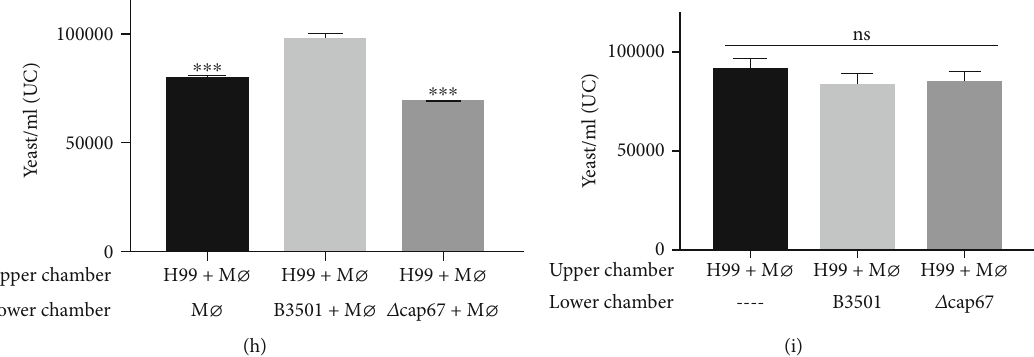
Figure 4: 1 kDa CM35 impacts phagocytic capacity and vomocytosis events in interactions between macrophages and C. neoformans . (a) Intracellular growth (CFU of 3 h vs. 24h postinfection) of yeasts cells in BMMs stimulated with LPS (500ng/ml) and H99 (2 :1), with or without inhibitors (10% v / v ). (b) Phagocytosis index (2 h postinfection) from BMMs stimulated with LPS (500ng/ml) and H99 (5 :1), with or without 1kDa CM35 (10% v / v ). (c – f) Flow cytometry analysis of (c, d) extracellular and (e, f) intracellular yeast cells (Calco fl uor White high 2 h, 6h, 12h, and 24h postinfection) from BMMs infected with H99 (10 :1), with or without 1 kDa CM35 (10% v / v ). (g) Scheme for transwell infection assay, illustrating the steps taken during the assay. (h, i) Flow cytometry measurement (24 h postinfection) of intracellular yeast cells in BMMs infected with H99 (2 :1), in the upper chamber of a transwell apparatus. In the lower chambers, BMMs were stimulated with LPS (500ng/ml) and B3501 or Δ cap67 (5 :1) (g). Alternatively, only yeast cells from B3501 or Δ cap67 in a media with LPS (500ng/ml) were included in the lower chambers (h). Statistical analysis was performed utilizing one-way ANOVA, where ns: not signi fi cant; ∗ P ≤ 0 : 033 ; ∗∗ P ≤ 0 : 002 ; ∗∗∗ P ≤ 0 : 001 . Comparisons were made with the B3501 lower chamber infected group